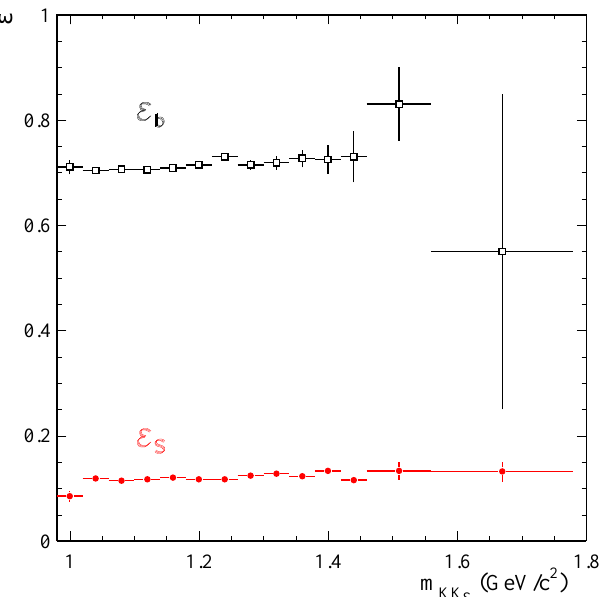
Figure 3: The probabilities ε mass, measured on simulated